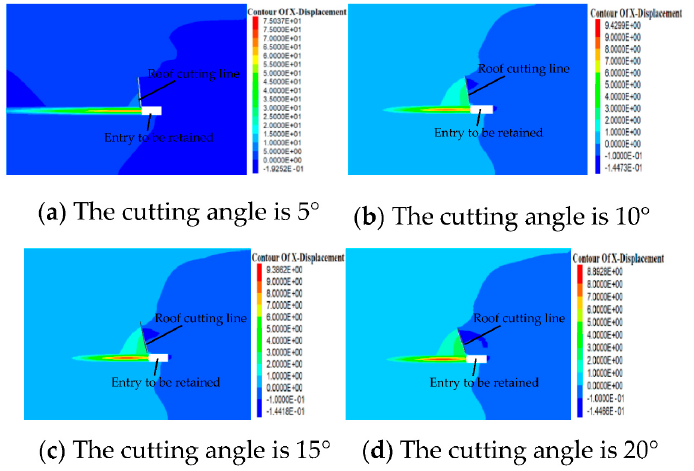
Figure 14. Horizontal displacement of roadway surrounding rock under different cutting angles.